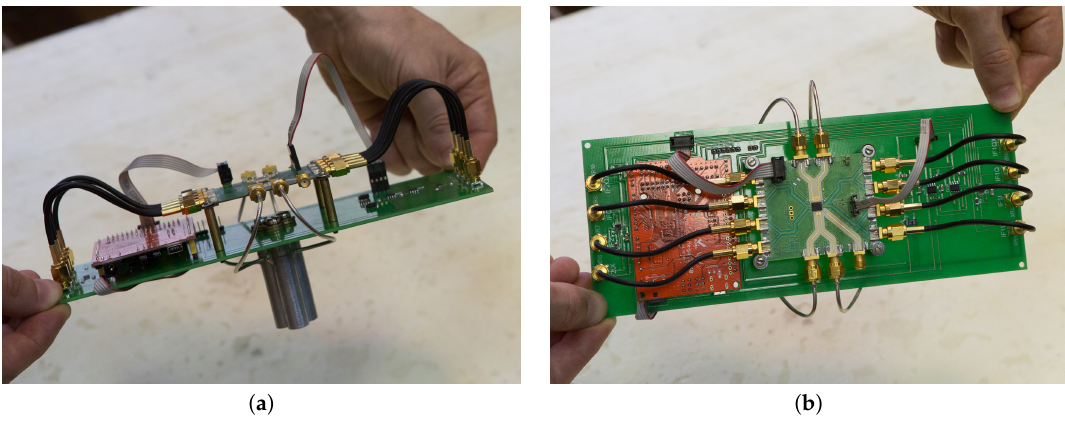
Figure 2. Photo of the radar: ( a ) side view; ( b ) top